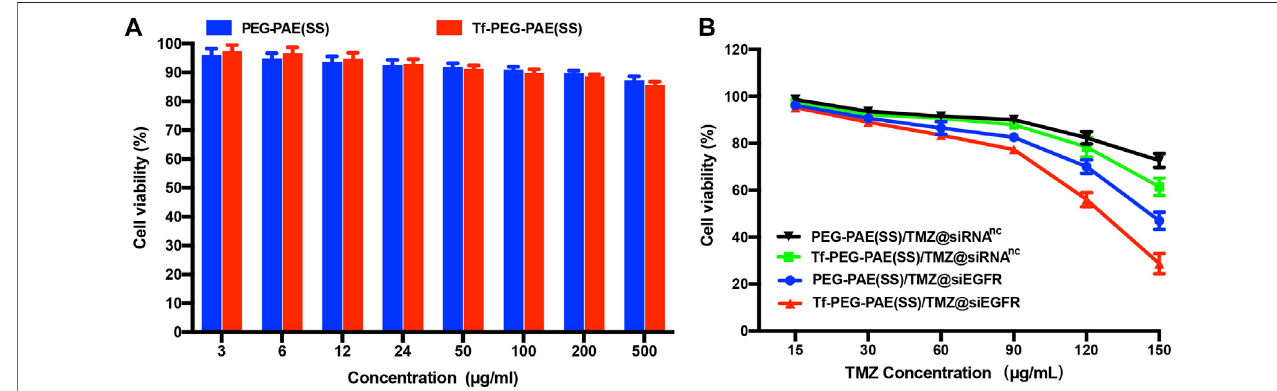
FIGURE5|(A) Invitro cytotoxicitiesofTf-PEG-PAE(SS)and PEG-PAE(SS) atdiverse concentrationsinU87cells. (B) Invitro cytotoxicities ofPEG-PAE(SS)/TMZ@ siRNA nc , Tf-PEG-PAE(SS)/TMZ@siRNA nc , PEG-PAE(SS)/TMZ@siEGFR, and Tf-PEG-PAE(SS)/TMZ@siEGFR at diverse concentrations in U87 cells.